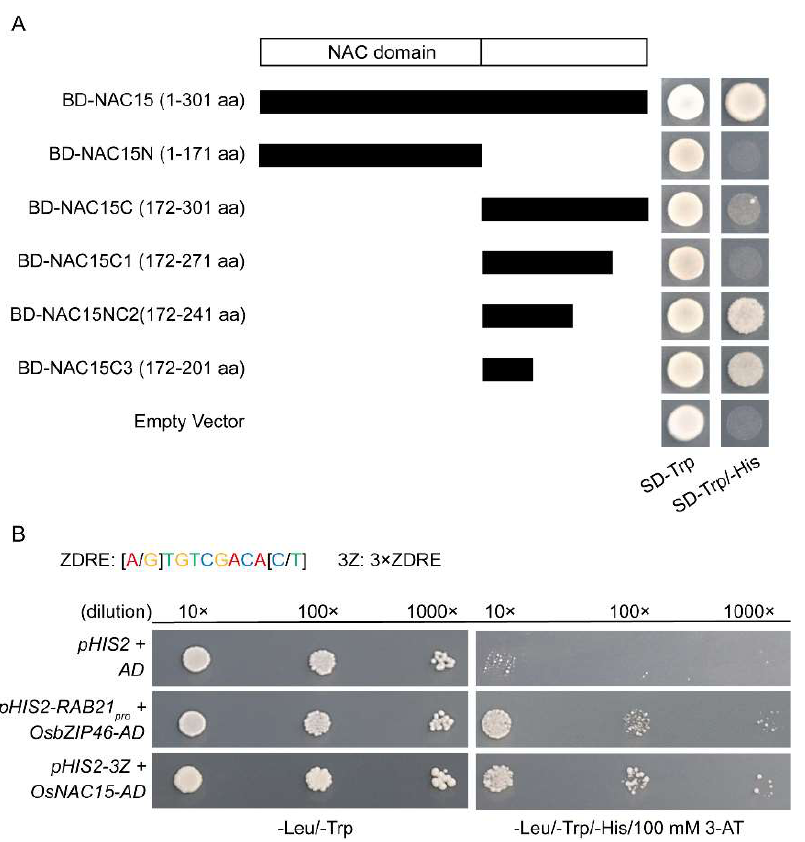
Figure 5. OsNAC15 functions as a transcription factor. ( A ) Transactivation activity of OsNAC15 in yeast. Schematic diagrams of the full-length and truncated OsNAC15 constructs are shown in the left panel. Yeast strain AH109 was used in the transactivation activity analysis. The transformants were streaked on the SD-Trp/-His media (right panel). ( B ) Yeast one-hybrid assay: OsNAC15 binds to the ZDRE motif; 100 mM 3-Amino-1,2,4-triazole (3-AT) was added in the SD-Leu/-Trp/-His medium. Interaction between OsbZIP46 and RAB21 was used as the positive control. Dilutions of 10×, 100× and 1000× correspond to an OD600 of 0.1, 0.01 and 0.001, respectively.